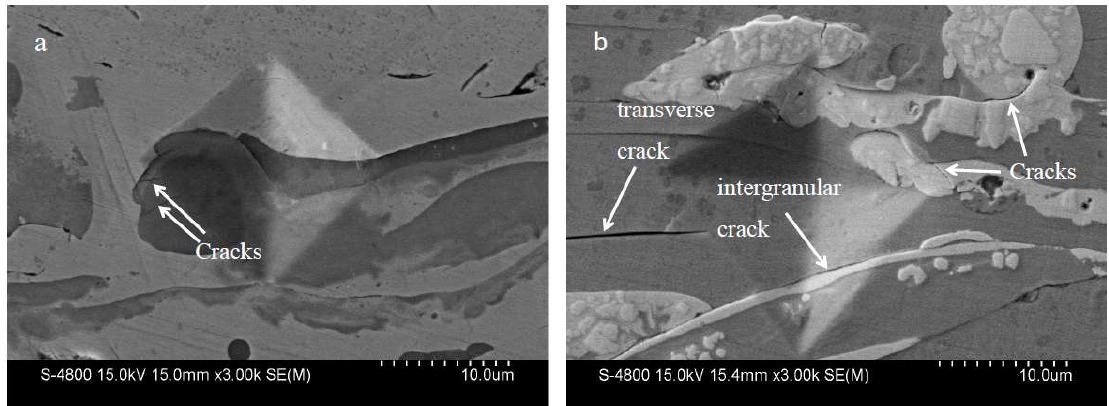
Figure 4. Cross-sectional SEM images of indentation morphology: ( a ) NTC coating; ( b ) NWC coating.